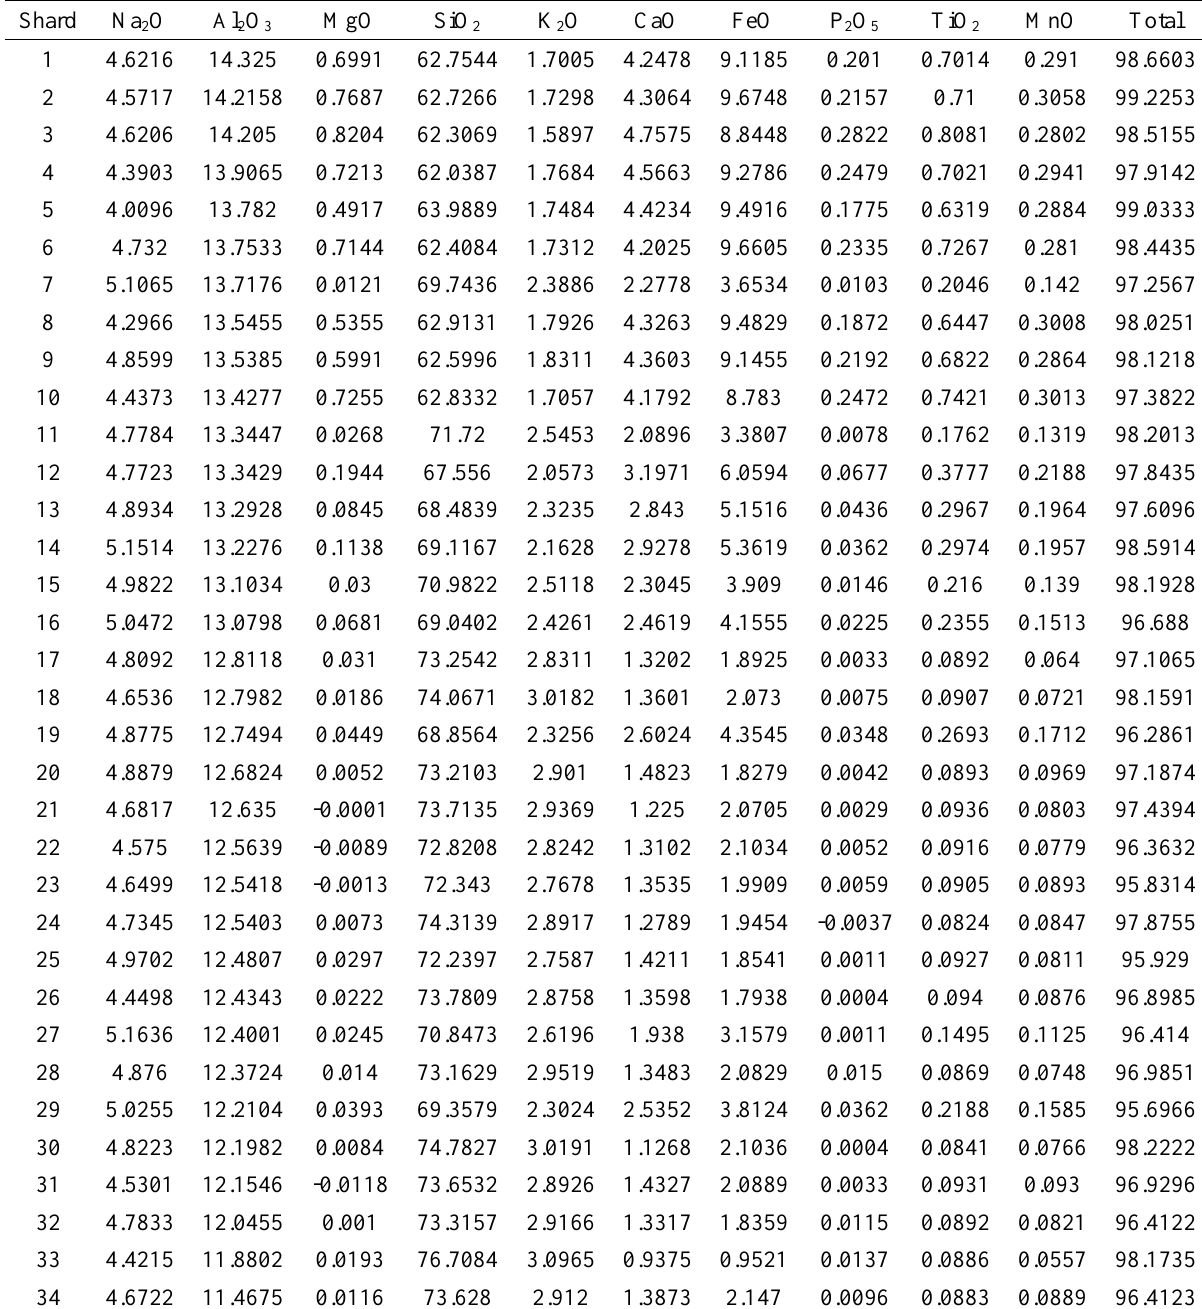
Table A1. Geochemistry from electronmicroprobe analysis of tephra shards found in the Cross Lochs Forest core at 122 cm, identified as Hekla